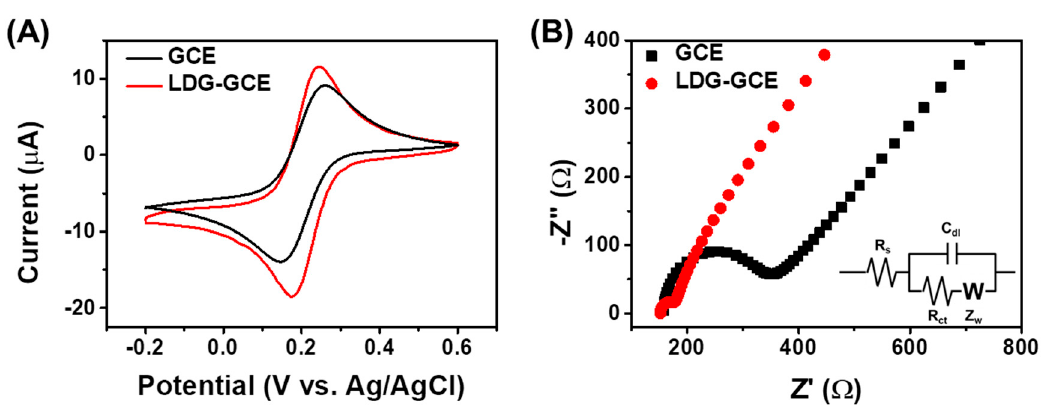
Figure 4. ( A ) CV curves of GCE (black) and LDG-GCE (red) in 0.1 M KCl containing 3 mM of K 3 Fe(CN) 6 . Scan rate: 50 mV/s. ( B ) The Nyquist plots of the GCE (black) and LDW-GCE (red) in 0.1 M KCl containing 3 mM of K 3 Fe(CN) 6 , using a frequency range of 0.1 to 10 5 Hz, a bias potential of +0.214 V and an AC amplitude of 10 mV. (Inset: Randles equivalent circuit model).